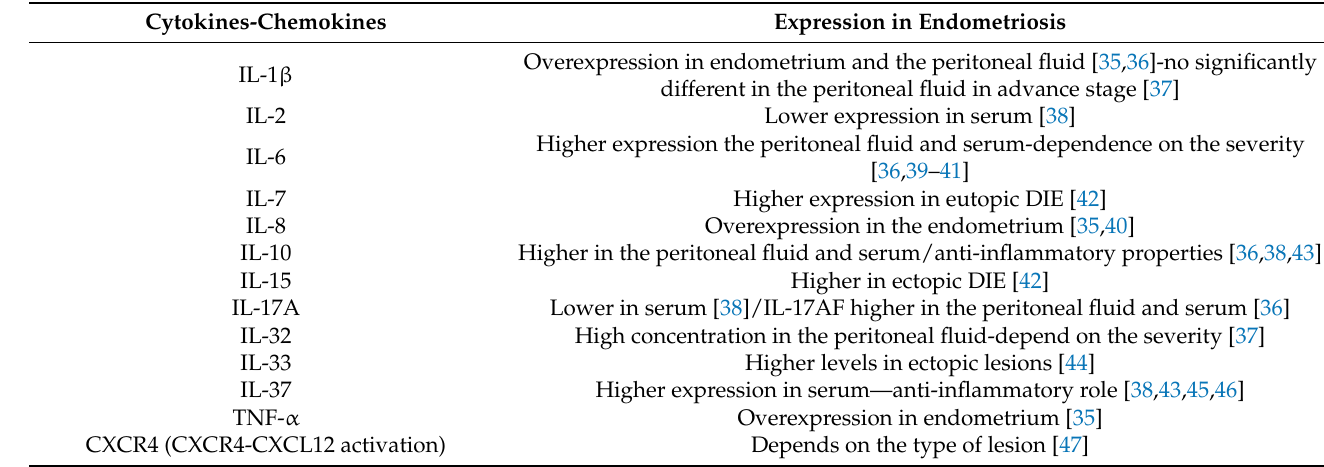
Table 1. Regulation of inflammatory mediators that are described in this review.